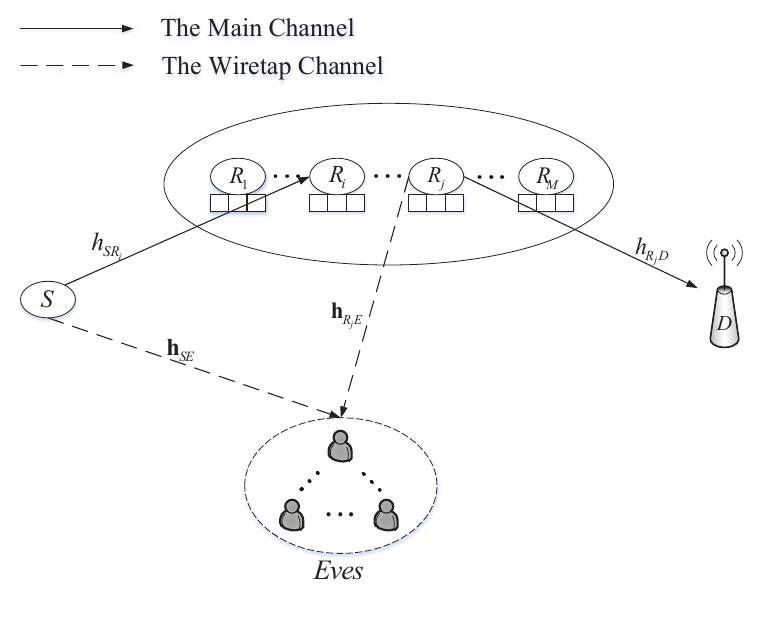
Figure 1. System